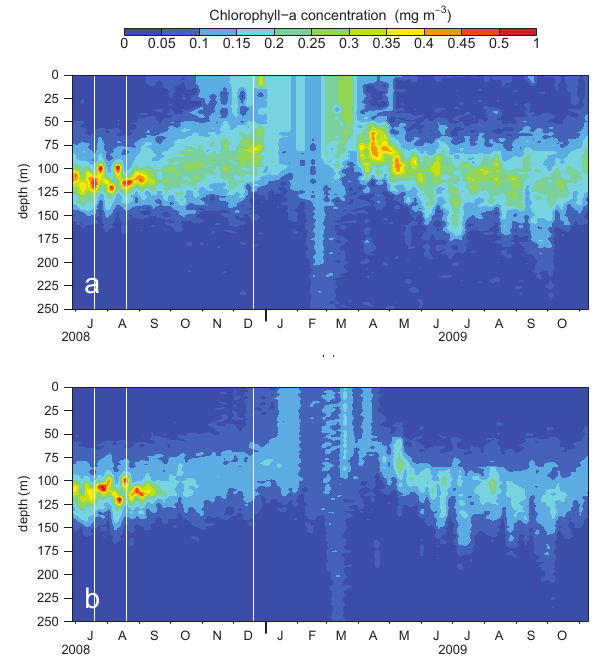
Fig. 7. Time series of Chl a C distribution estimated with a fluorom- eter deployed on a profiling float in the Levantine Sea and processed with the present method (a) and with the Boss et al. (2008) method (b)